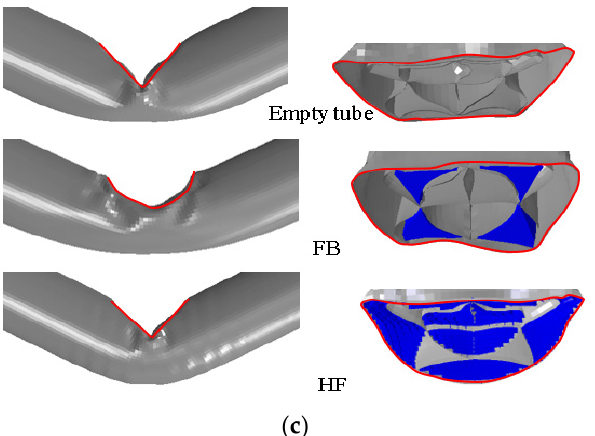
Figure 9. Comparison of filled structures: ( a ) force–displacement diagram; ( b ) SEA-displacement diagram; ( c ) deformation mode.